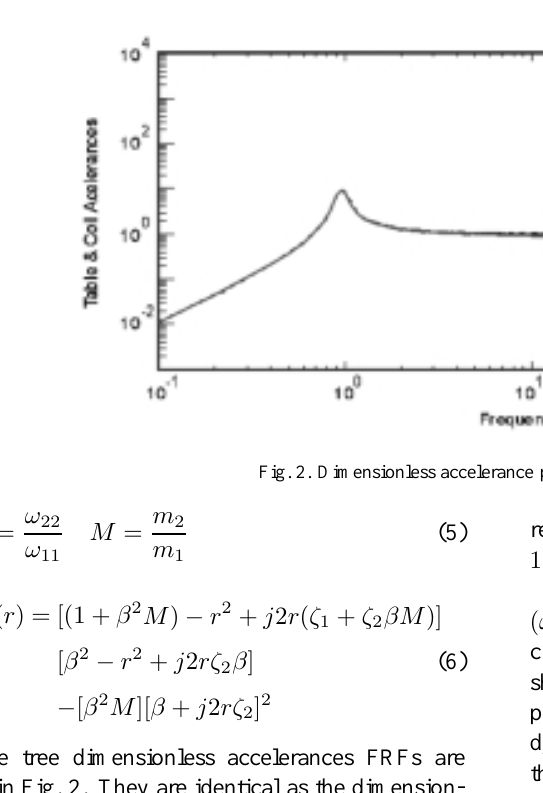
Fig. 1. Armature 2 DOF dynamic model.